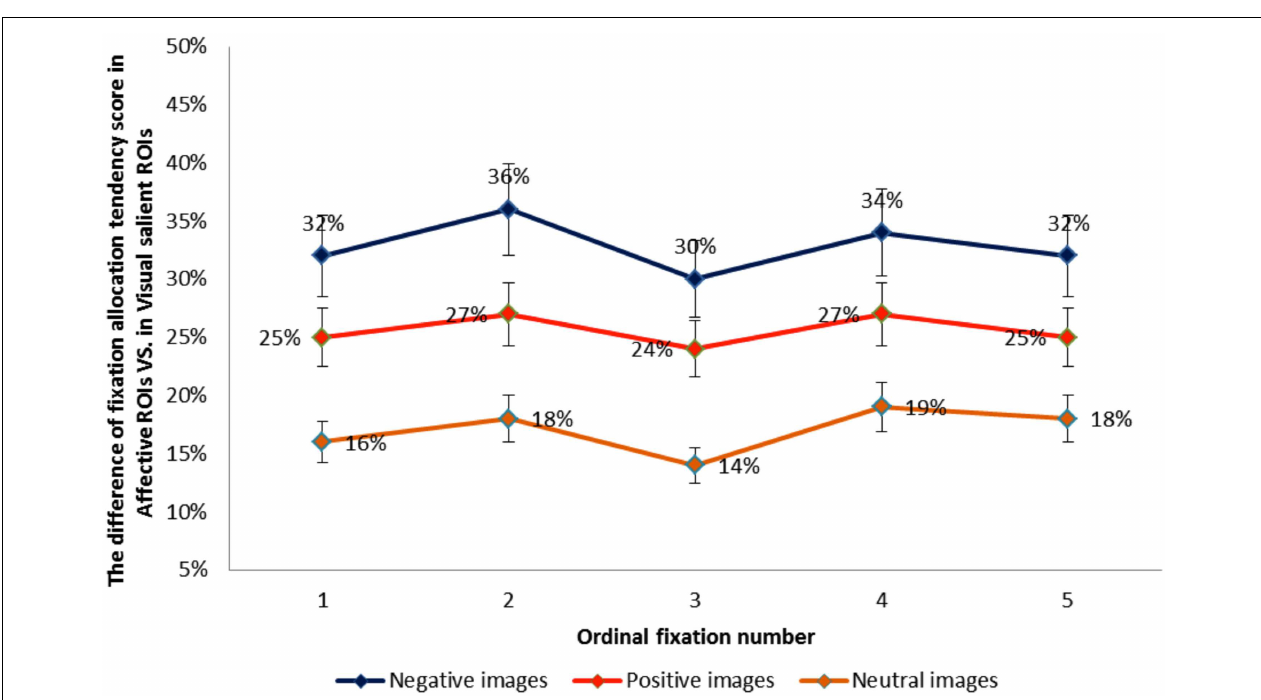
FIGURE 4 |The difference between fixation allocation tendency scores in the visual vs. affective ROIs for each emotion category as a function of ordinal fixation